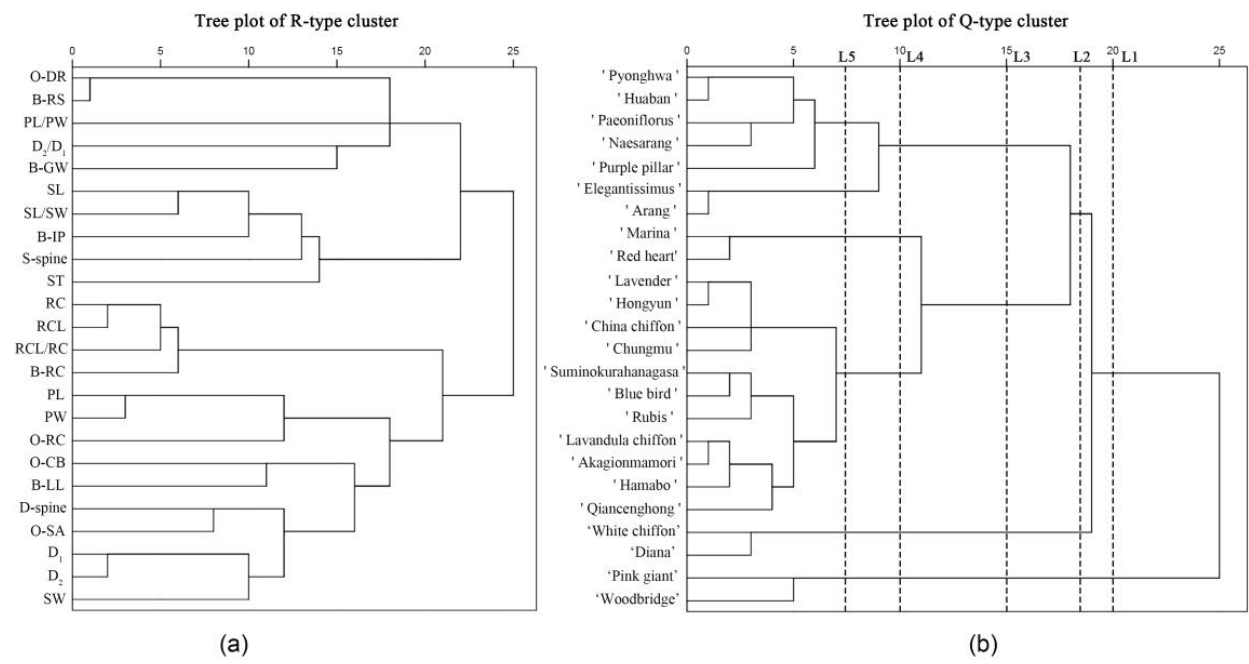
Figure 6. Tree plot of R-type cluster and Q-type cluster of Hibiscus syriacus . ( a ) R-type conducted on 24 combined morphological traits based on between-groups linkage method. ( b ) Q-type conducted on Hibiscus syriacus 24 cultivars based on ward